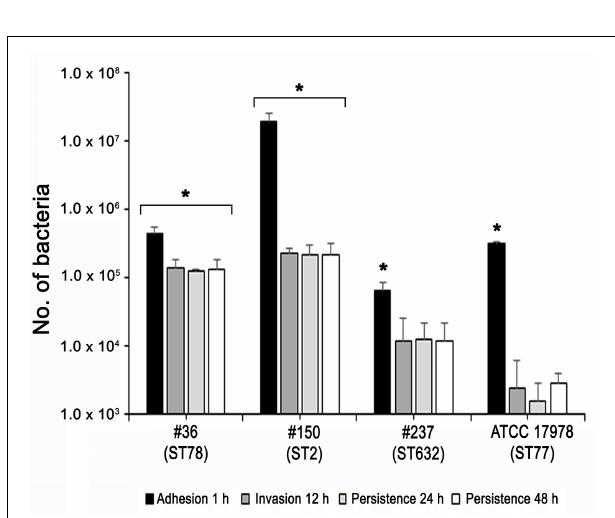
FIGURE 5 | Ability of CRAb to adhere to, be internalized, and survive within cultured epithelial cells. Semi-confluent A549 cell monolayers were infected with each isolate or ATCC 17978 reference strain using a multiplicity of infection (MOI) of 100. Cell-surface-adherent bacteria were enumerated after 1-h incubation, whereas intracellular bacteria were counted after additional 12, 24, and 48-h of incubation in the presence of colistin (5 µ g/ml). Data (CFU/ml) are means ± standard deviation from at least three independent experiments, in duplicate. Asterisks ( ∗ ) above the bars indicates a statistically significant difference among isolates ( P -values < 0.01). Uninfected cells were used as control.